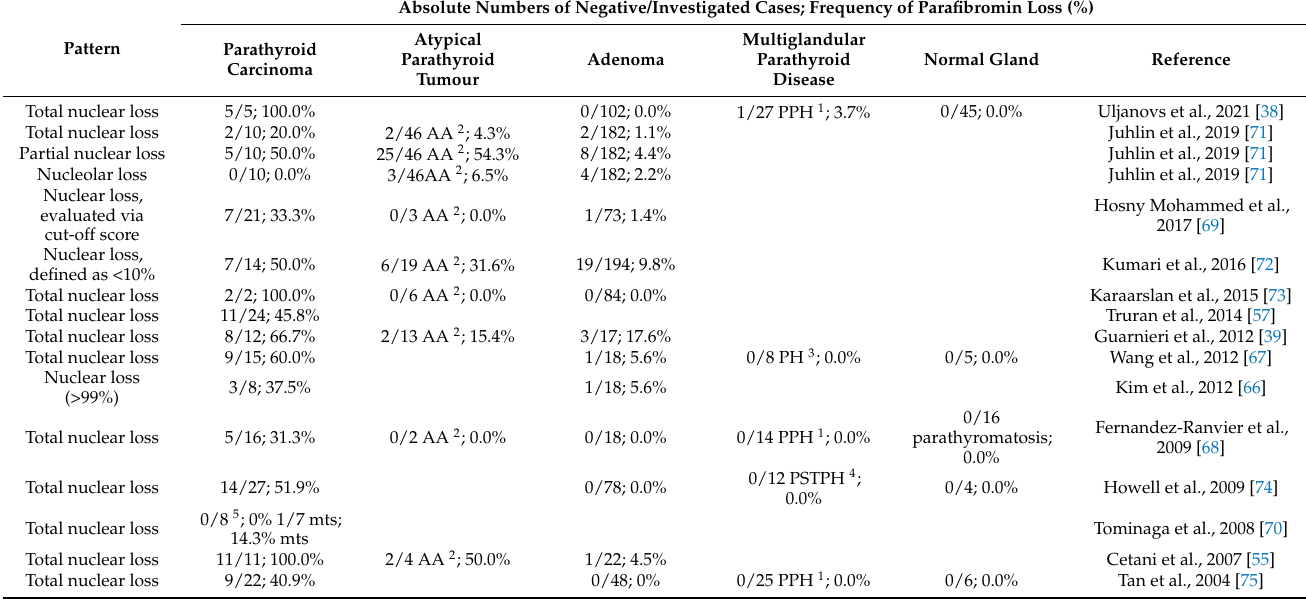
Table 2. Loss of parafibromin expression in parathyroid tumours and